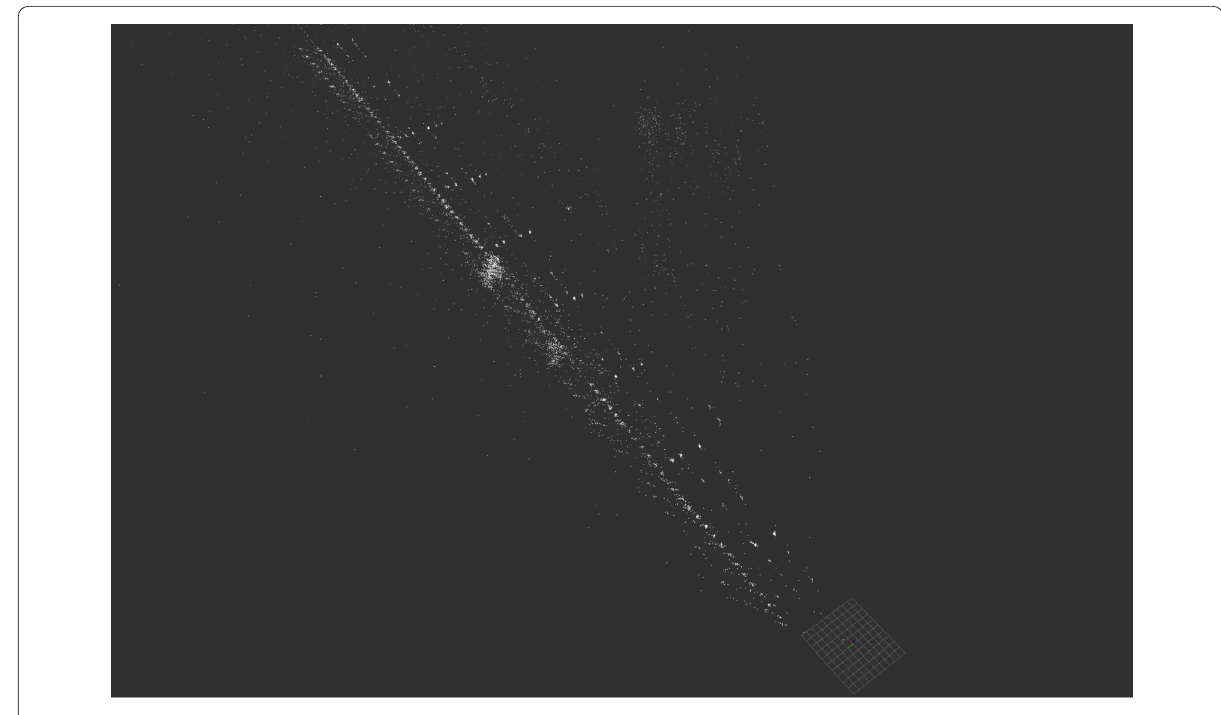
Figure 6 Created point cloud based on detected feature points using ORB-SLAM